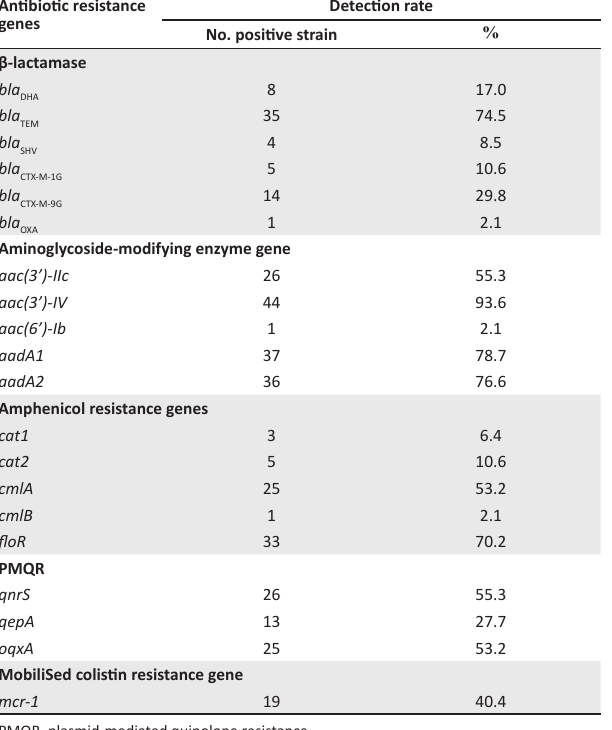
TABLE 3: Detection rate of antibiotic resistance genes in 47 Escherichia coli isolates. Antibiotic resistance genes